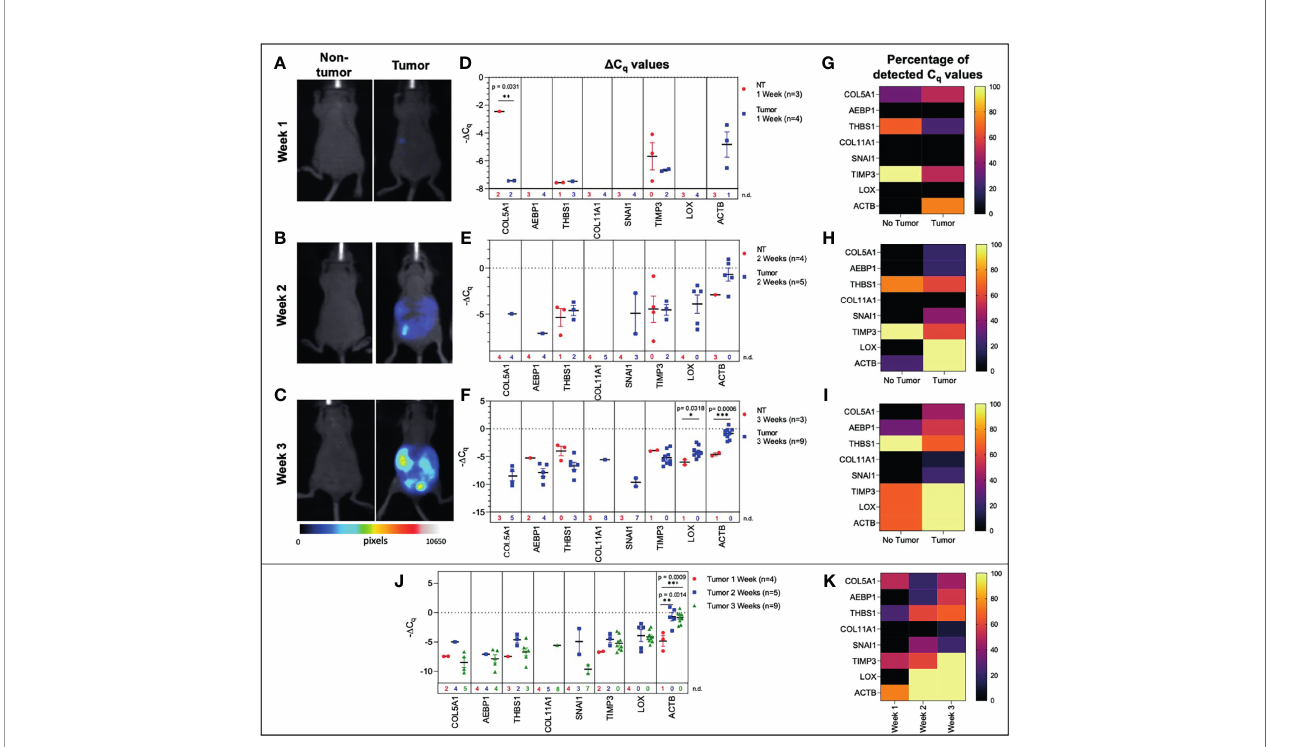
FIGURE 3 | Plasma-derived sEV gene expression in a mouse model of ovarian cancer. Representative fl uorescent imaging of SKOV-3/RFP cells in tumor-bearing and non-tumor-bearing mice in (A) Week 1, (B) Week 2, and (C) Week 3. Scatter plots of D C q values at (D) Week 1 for tumor- (blue, n=4) and non-tumor-bearing samples (red, n=3), (E) Week 2 for tumor- (blue, n=5) and non-tumor-bearing samples (red, n=4), and (F) Week 3 for tumor (blue, n=9) and non-tumor-bearing samples (red, n=3). Heat maps showing the percentage of detected C q values at (G) Week 1, (H) Week 2, and (I) Week 3. (J) Scatter plot of D C q values for tumor- bearing samples over Weeks 1-3 of tumor development; (K) Heat map showing the percentage of detected C q values in tumor-bearing samples for Weeks 1, 2, and 3. p values for unpaired two-tailed t-test are labeled in the graphs. The number of non-detected (n.d.) C q values in each experimental group are listed underneath the corresponding scatter plots. Heat maps in g, h, i, and k indicate the absence/presence of the target gene (percentage of detected C q values) in each experimental group. *p<0.05, **p<0.01, ***p<0.001,